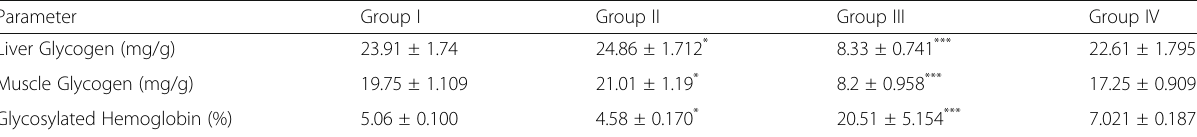
Table 2 The effect of Momordica charantia on Liver Glycogen, Muscle Glycogen and Glycosylated Heamoglobin in normal and diabetic rats